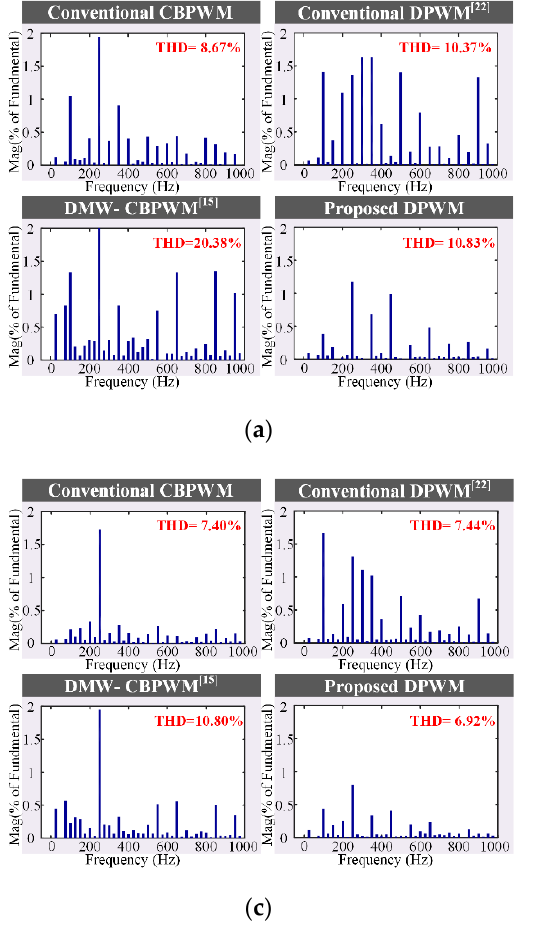
Figure 14. Harmonic spectra of i A under different modulation index conditions. ( a ) m = 0.3, cos θ = 0.954; ( b ) m = 0.8, cos θ = 0.954; ( c ) m = 0.3, cos θ = 0.732; ( d ) m = 0.3, cos θ = 0.732.